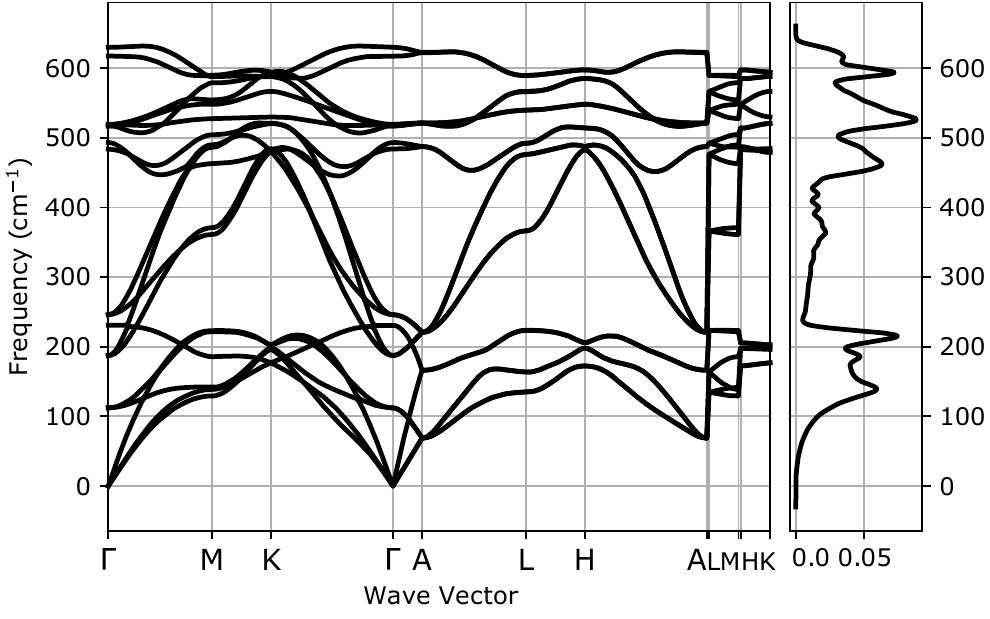
Figure 3. ZrB 2 ( hP6 -P6 3 /mmc-space group, no. 194)-phonon band structure and